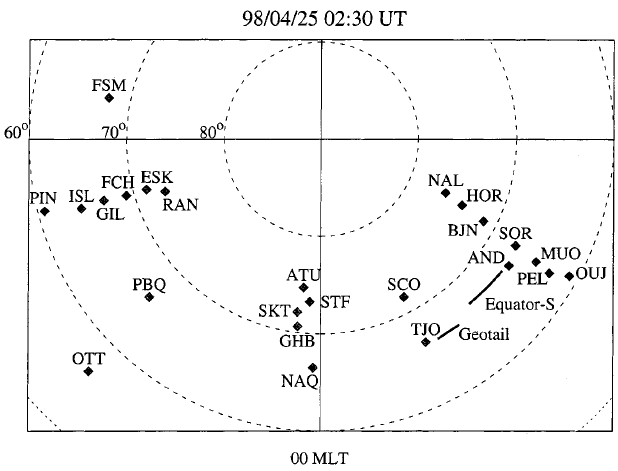
Fig. 1. Distribution of the ground-based stations in the nightside sector together with the estimated foot point of Geotail and Equator-S in corrected geomagnetic coordinates. Positions are shown so that local midnight for 0230 UT is directed downward in the figure. The location of the foot point was obtained using the Tsyganenko 89 model for 0200 and 0300